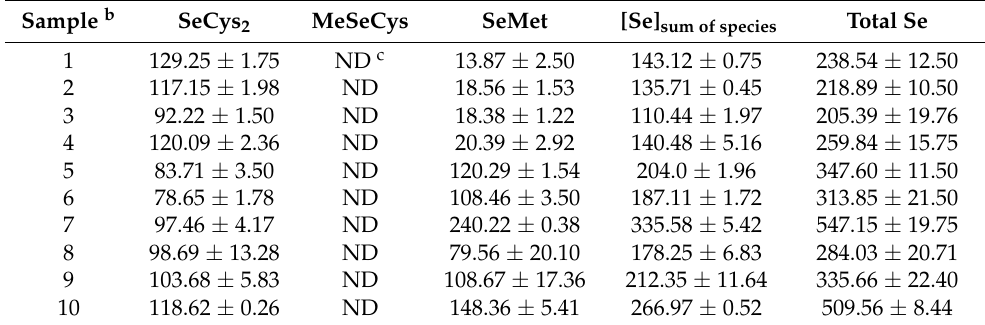
Table 3. Results of Se speciation analysis in different egg samples a .